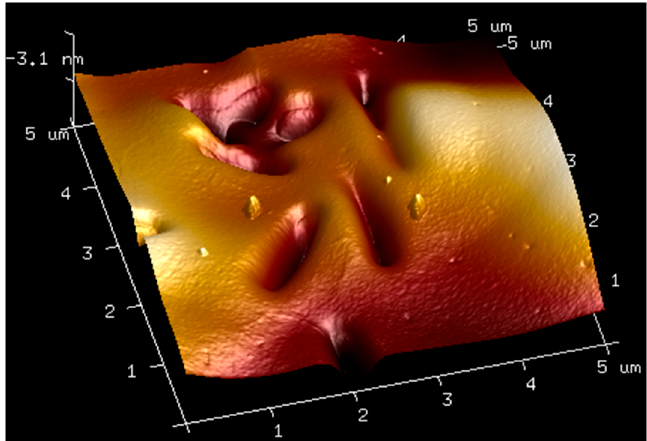
Figure 7. AFM visualization of the surface of film obtained from the solution of 1.5% high-molecular HA with 1% BSA.